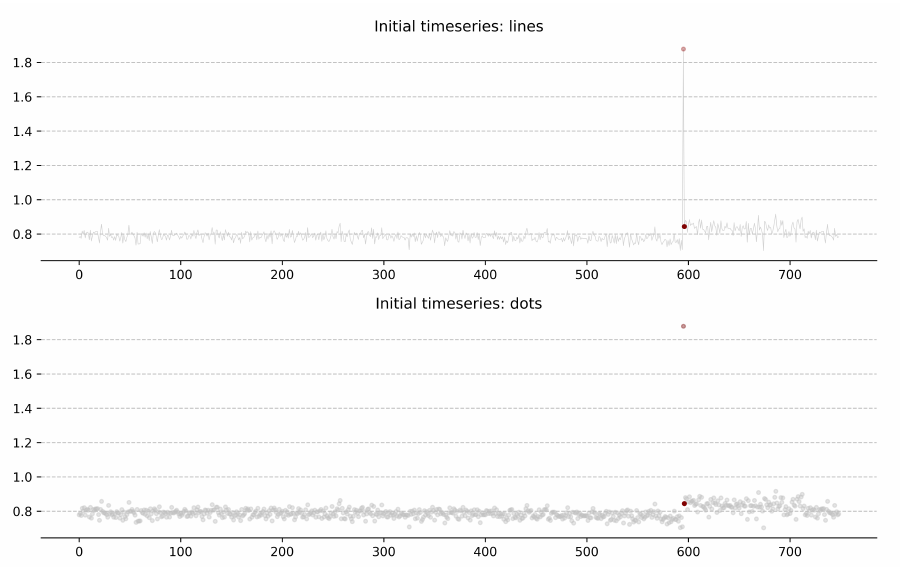
Figure 6. Artificially made time-series with outliers to demonstrate the approach. It is a simple time series with the first outlier as the first value other than 0. Hereinafter, anomalies are marked with red dots.